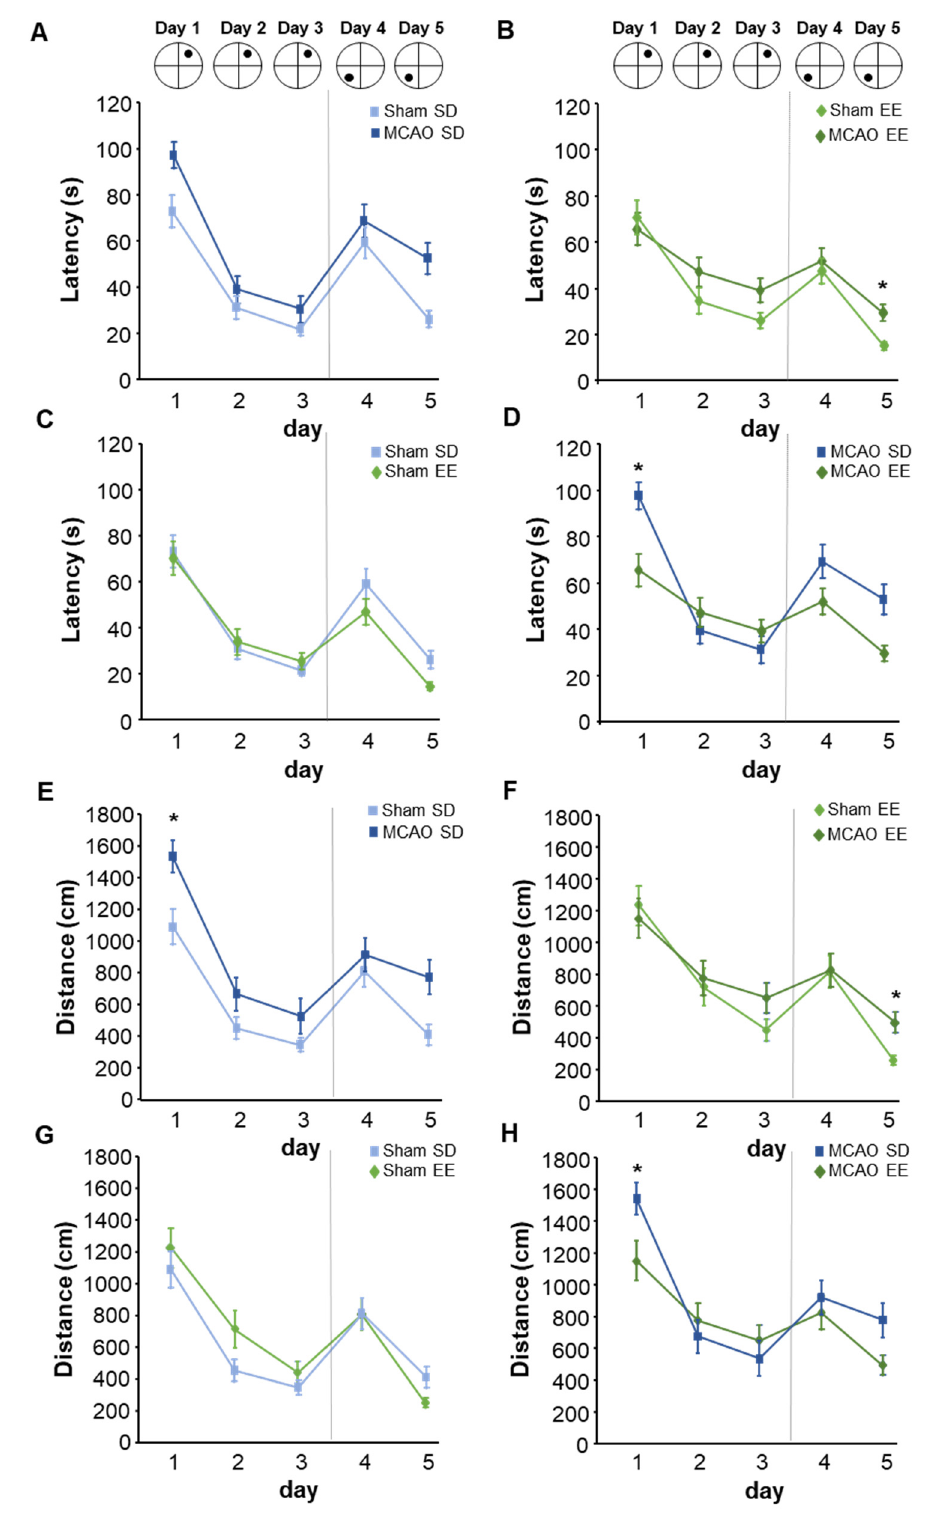
Figure 7. Learning and re-learning in dependence of stroke and EE housing. The graphs show ( A – D ) latency and ( E – H ) distance of navigation to the hidden platform in the Morris water maze. ( A , E ) Impairments in learning were evident in the standard housing group when comparing sham and MCAO. ( B , F ) By re-learning the new platform position, sham-EE animals, in particular, showed an improvement compared with the MCAO-EE mice. ( C , G ) There were no differences between the sham groups. ( D,H ) Between the MCAO groups in the different housing conditions, there was a